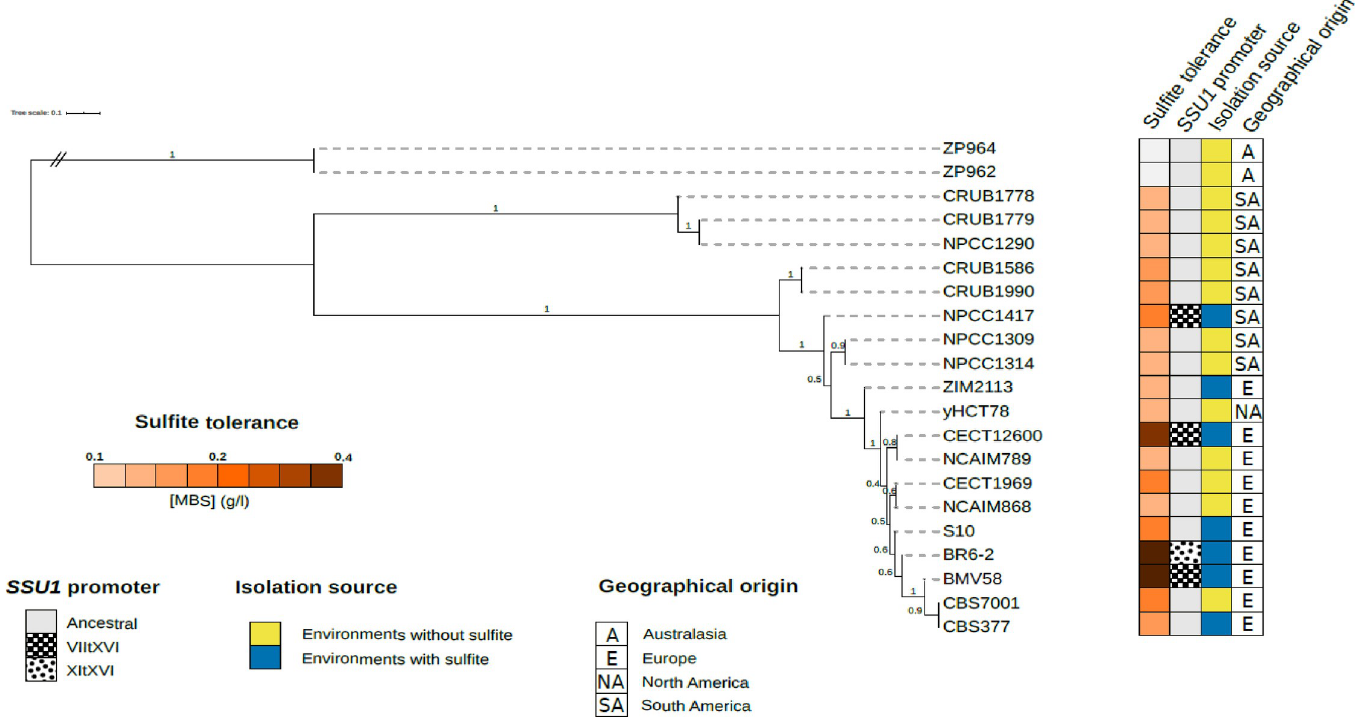
Fig 4. Phylogenetic analysis of the S . uvarum sequenced genomes. Phylogeny obtained with ASTRAL-III for 1265 unrooted individual gene trees shared among the 21 S . uvarum strains. Branch-support values, ranging from 0 to 1, are located at the nodes and represent the support for a quadripartition. The tree was rooted using ZP962 and ZP964 from the Australasian population as outgroups. A heatmap next to the branch labels shows the sulfite tolerance of the strains, SSU1 promoter variant, and the isolation source. Sulfite tolerance was measured by drop test assay and it is color-coded from minimum (0 g/l) to maximum (0.4 g/l) MBS concentration. Strains were divided according to their isolation source taking into account whether the isolation environment contained sulfite used as a preservative or not. Finally, ancestral SSU1 promoter strains (strains without any translocation in the promoter) and the two different chromosomal translocation events found are shown.